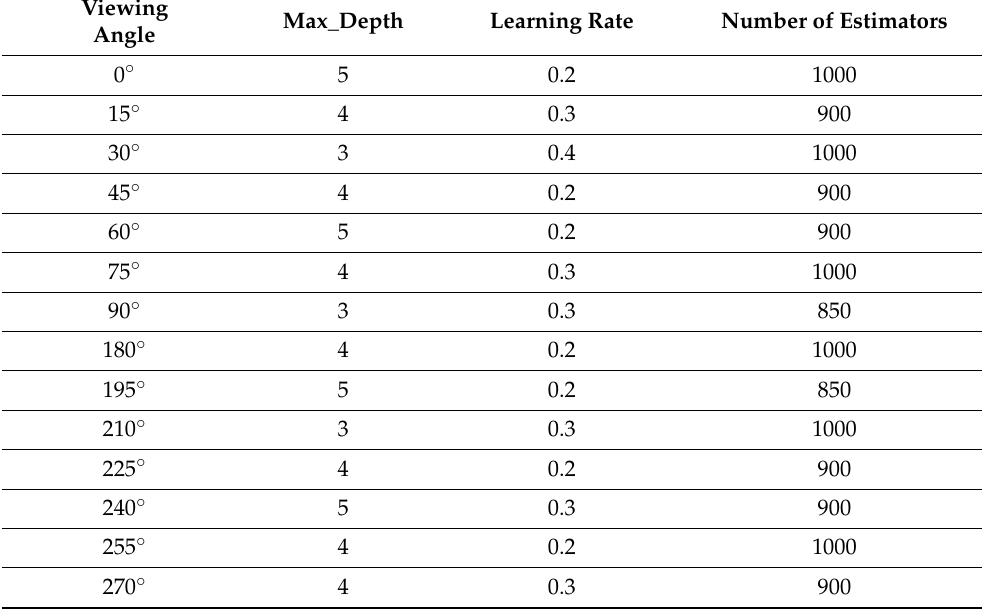
Table 1. Illustration of XGBoost parameters tuning with respect to viewing angle